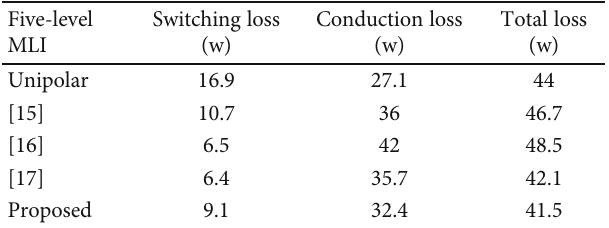
and V or V and V , DC DC 5 6